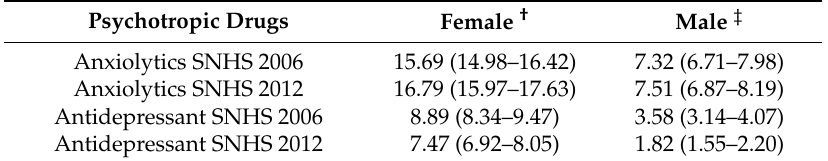
Table 1. Anxiolytics and antidepressant drug used in Spanish adult population. Spanish National Health Surveys (SNHS) 2006 and 2012 (Percentage and 95% Confidence